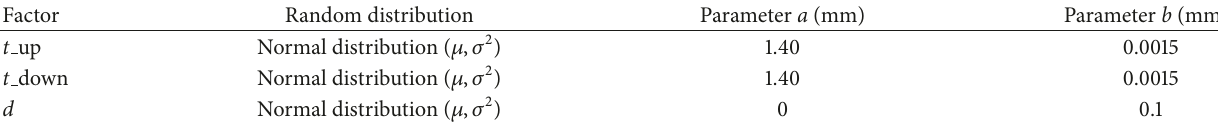
Table 10: Random distribution table of design variables.